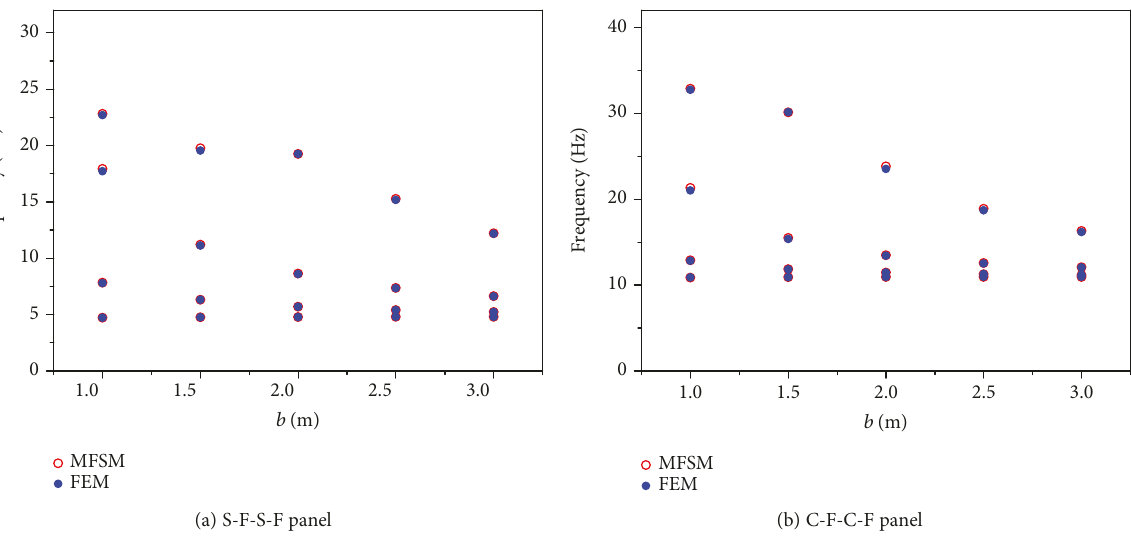
Figure 4: The 1st, 2nd, 3rd, and 5th frequencies of the panel with di ff erent